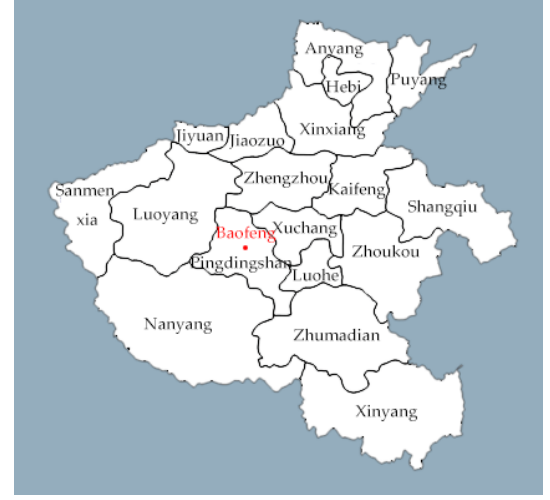
Figure 2. Location map of the study area.